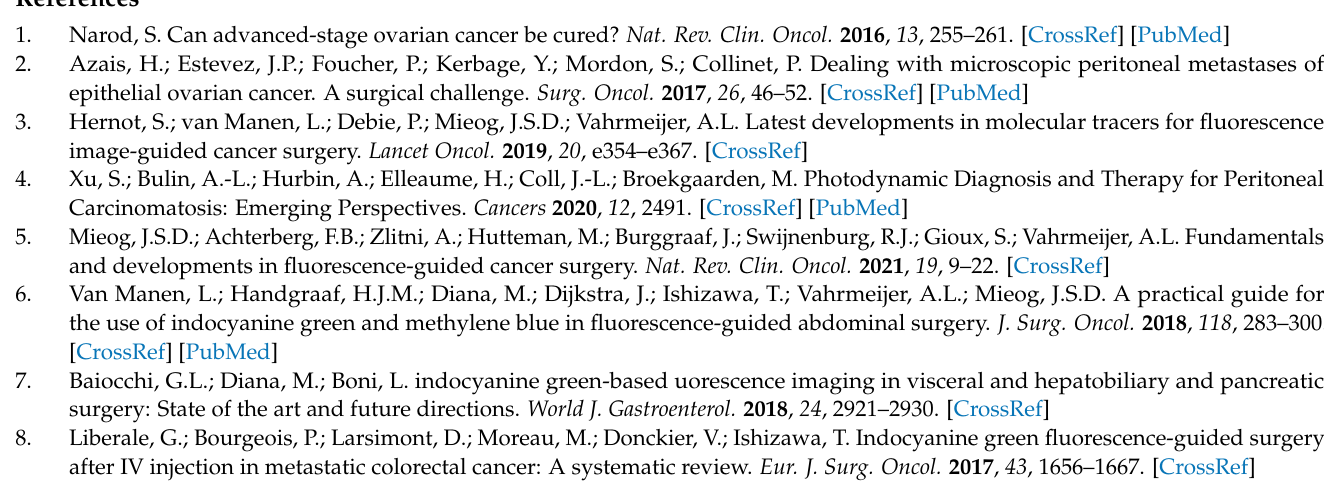
Table S1: Molecular probes and